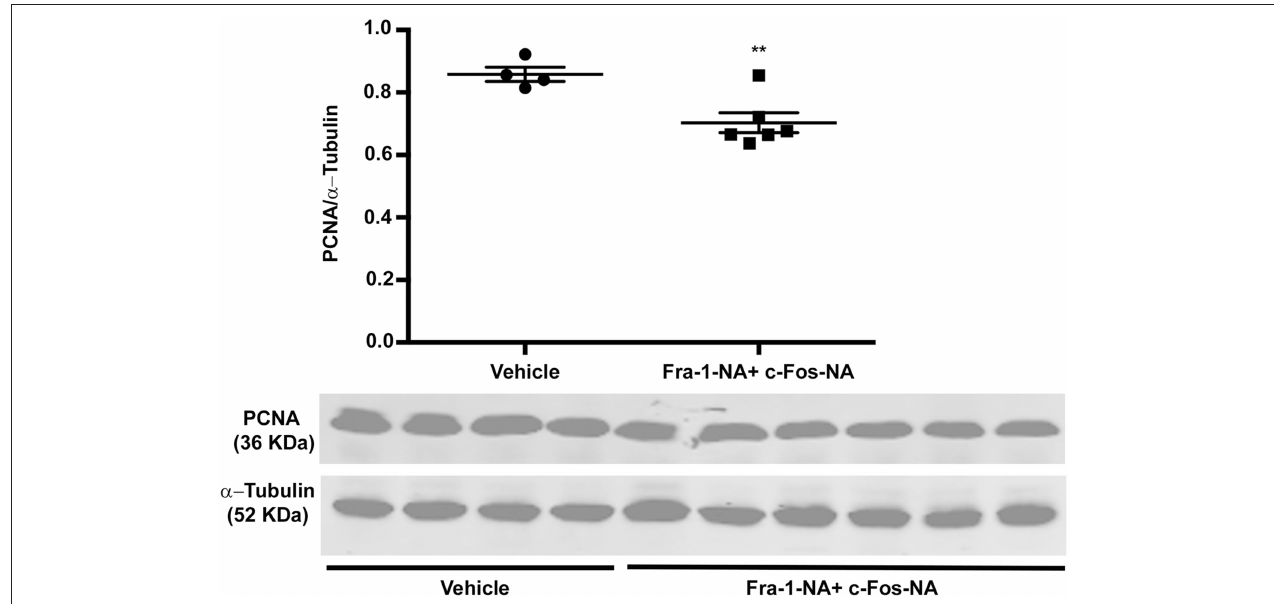
FIGURE 6 | Fra-1-NA plus c-Fos-NA treatment decreases PCNA protein levels. Protein extracts prepared from the tumors excised from tumor-bearing Balb/c mice treated or not with Fra-1-NA plus c-Fos-NA were subjected to western blot analysis to examine PCNA and α -tubulin (as loading control) levels as described under Materials and Methods. PCNA and α -tubulin levels of all the tumors of the high dose treatment experiment with their controls are shown. Scatter dot plot represents the densitometric quantification and horizontal bars the mean ± SEM (Student t -test). ** p < 0.01. Control group: n = 4; treated group: n = 6.